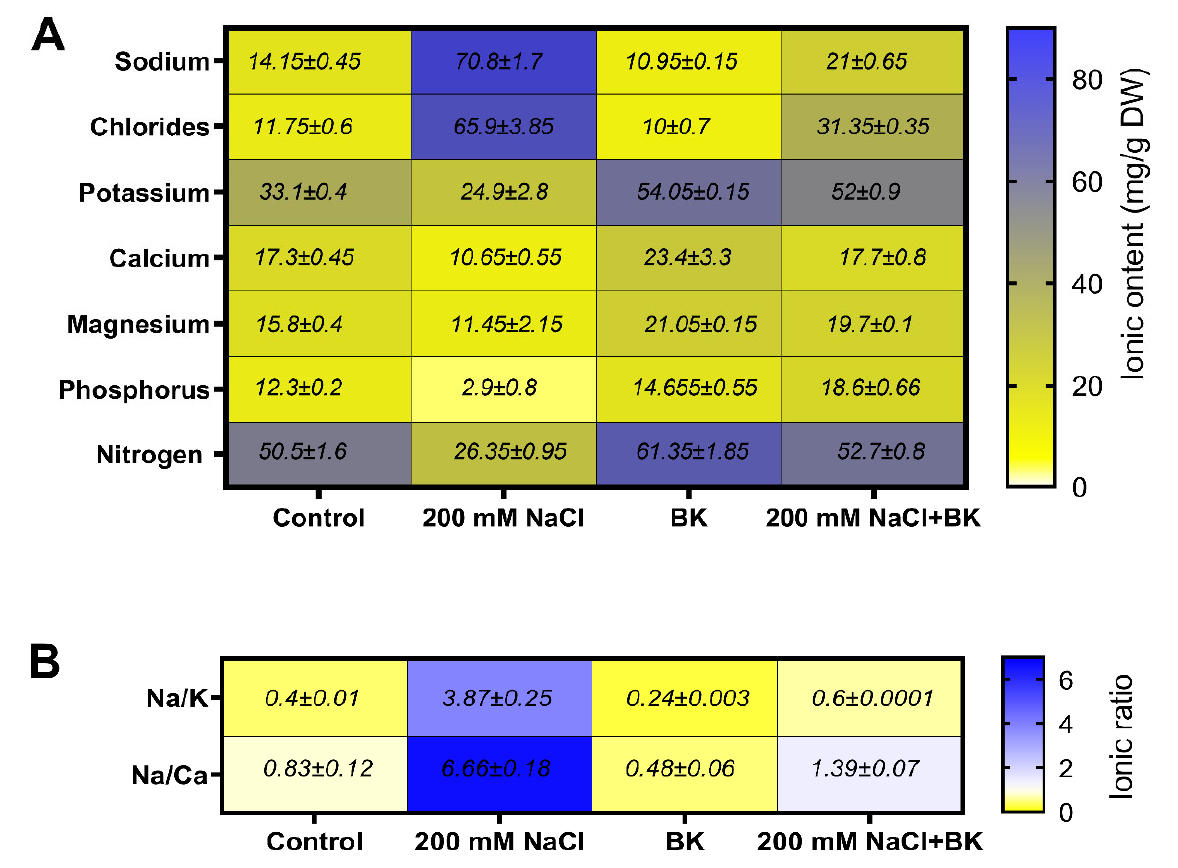
Figure 7. Influence of A. welwitschiae BK on the concentration of different ions. ( A ) Sodium, chloride, potassium, calcium, magnesium ions and nitrogen, phosphorus mineral elements ( B ) K + /Na + and Na + /Ca 2+ ion ratios in maize plants grown under salt stress. Data represent the means and SE of three independent replicates for each treatment. Signi fi cant data ( p ≤ 0.05) presents the mean ± SD.